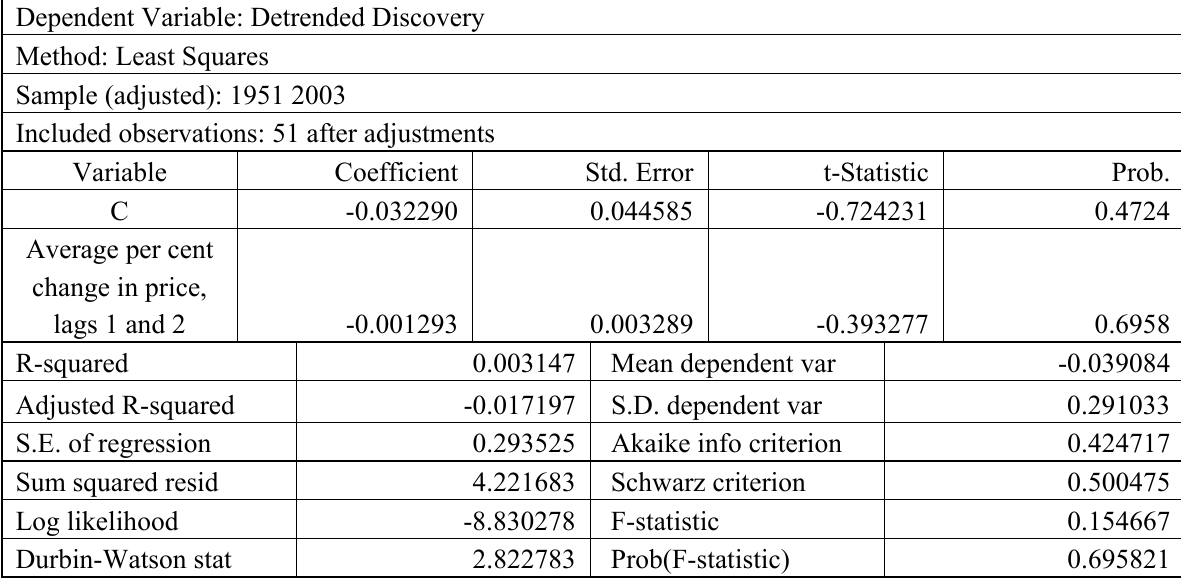
Table 9. Detrended Discovery with lags.